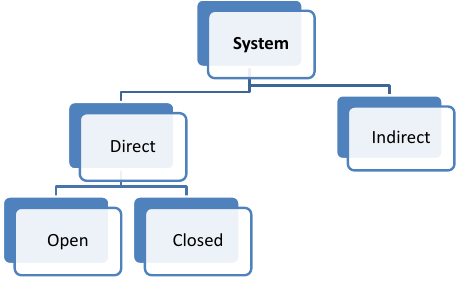
Figure 2. Classification according to the system.